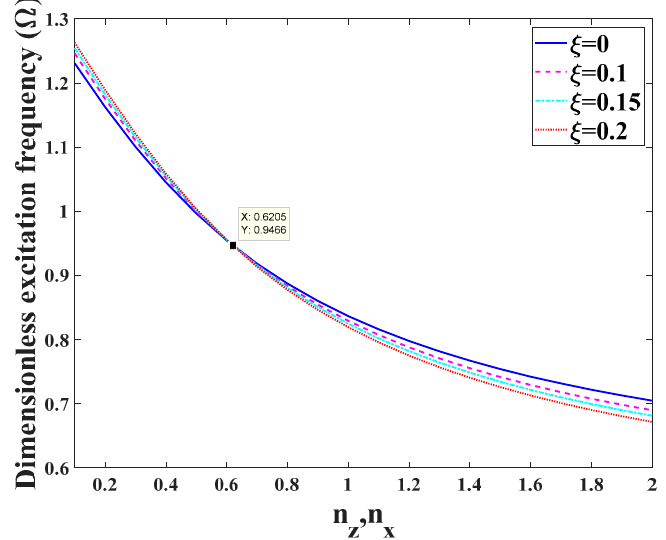
ξ on the dimensionless excitation frequency